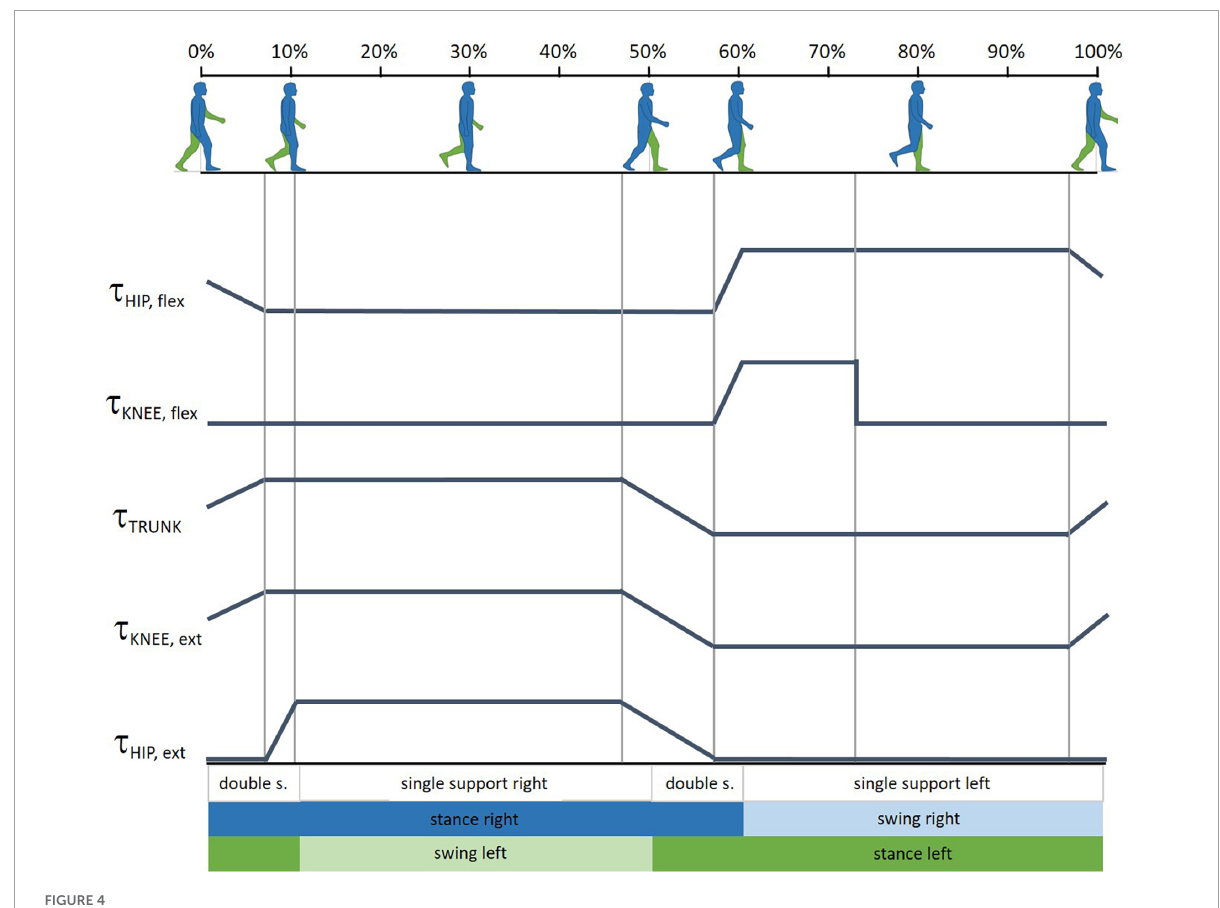
FIGURE4 Gait cycle phases and the timing profiles of the assistance provided at articular joints at T1.4. τ HIP , flex and τ KNEE , flex are the assistive torque, respectively, provided at the hip and knee joint during the toe-off phase of the non-paretic leg; τ TRUNK is the pelvic tilt dumping during stance phase; τ KNEE , ext provides stabilization of the knee joint of the support leg; τ HIP , ext helps the extension of the paretic leg during stance phase. Gait phase graphics modified from BoH–Own work, CC BY-SA 4.0,